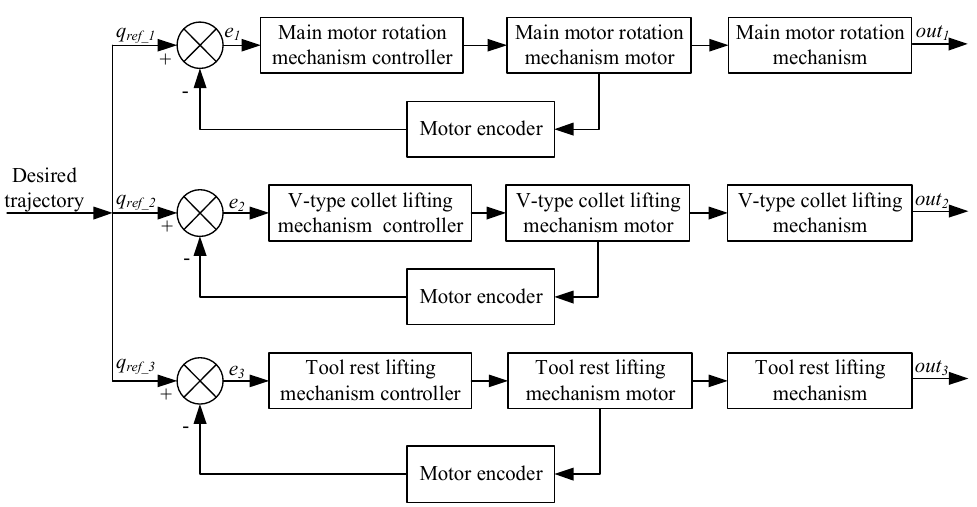
Figure 4. Motion control scheme of the cable- stripping robot.